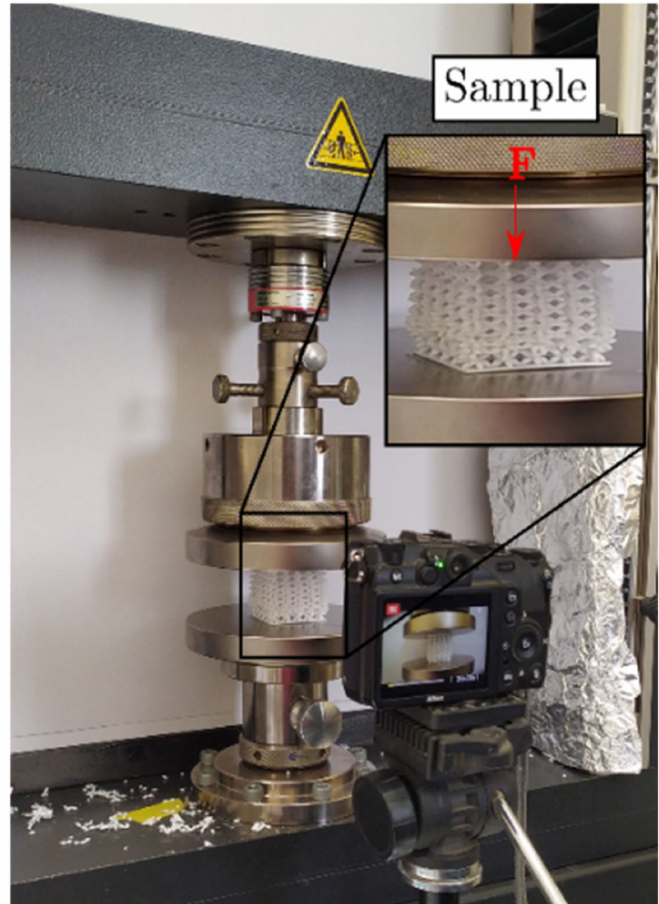
Figure 8. Experimental setup for compressive